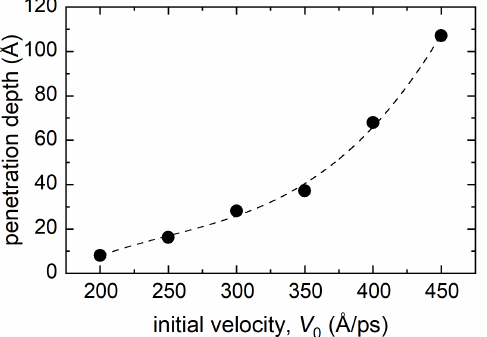
Figure 6. Dependence of penetration depth of the bombarding atom located at the center of the octahedral channel (case I) at different initial velocities. The dashed line depicts the fit with a cubic polynomial.